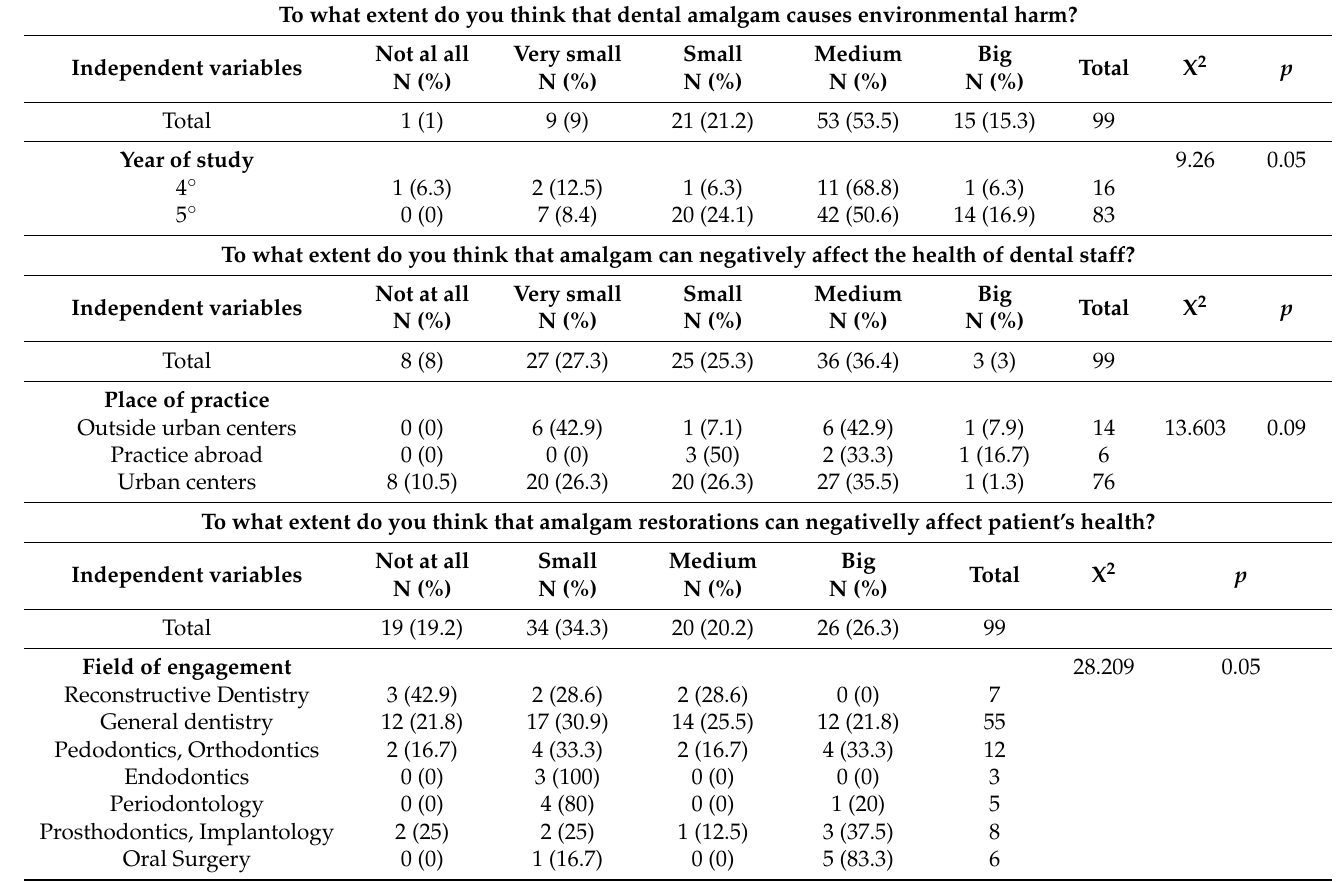
Table 2. Significant values for